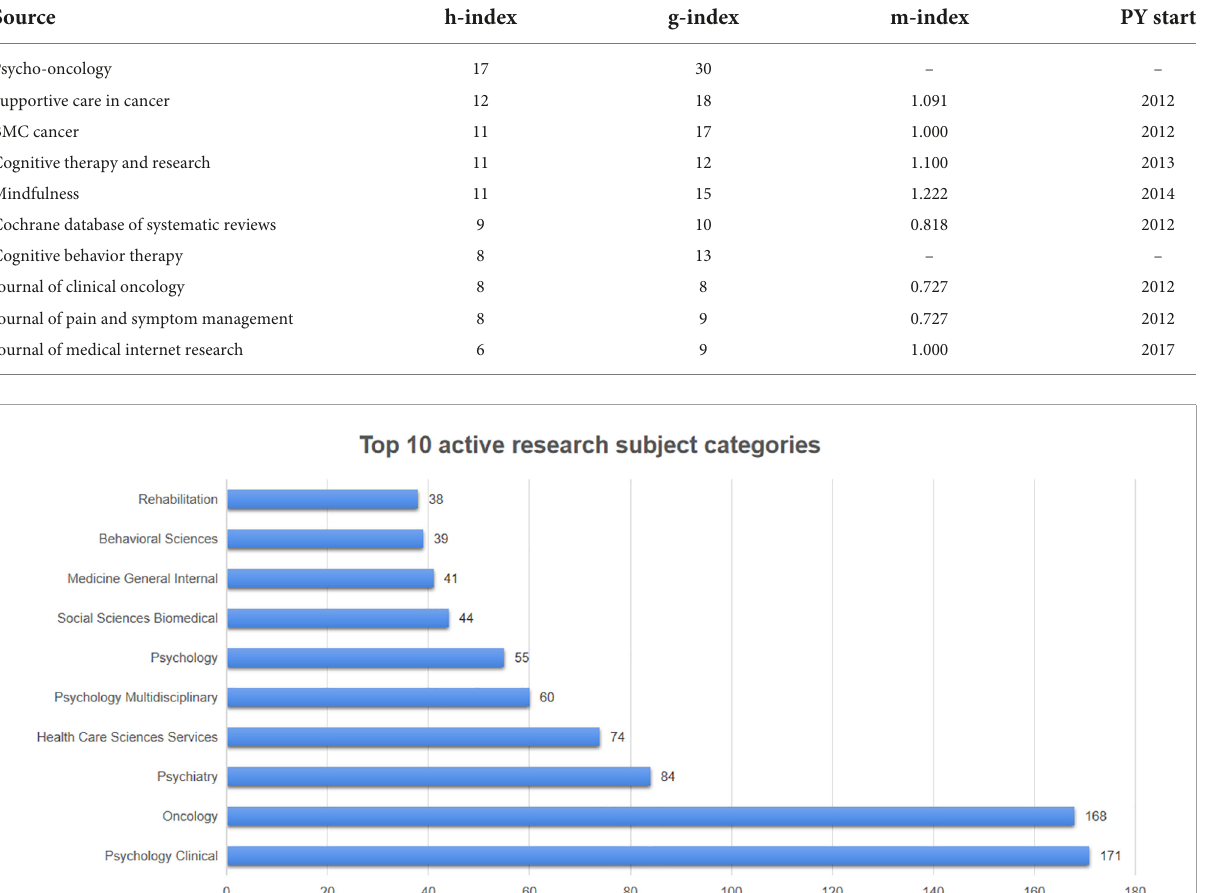
FIGURE7 Top 10 active research subject categories.